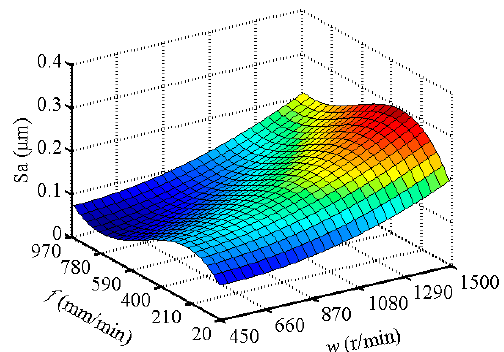
Figure 14. Surface graphs of Sa regression model.